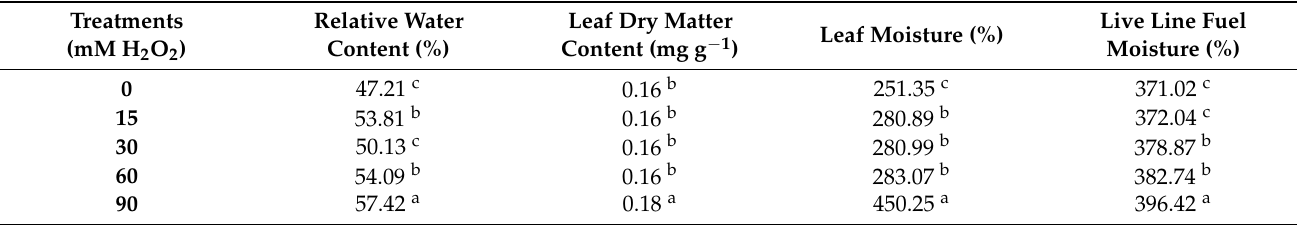
Table 2. Effects of different treatments of H 2 O 2 on relative water content, leaf dry matter content, leaf moisture, live line fuel moisture of F. deltoidea .